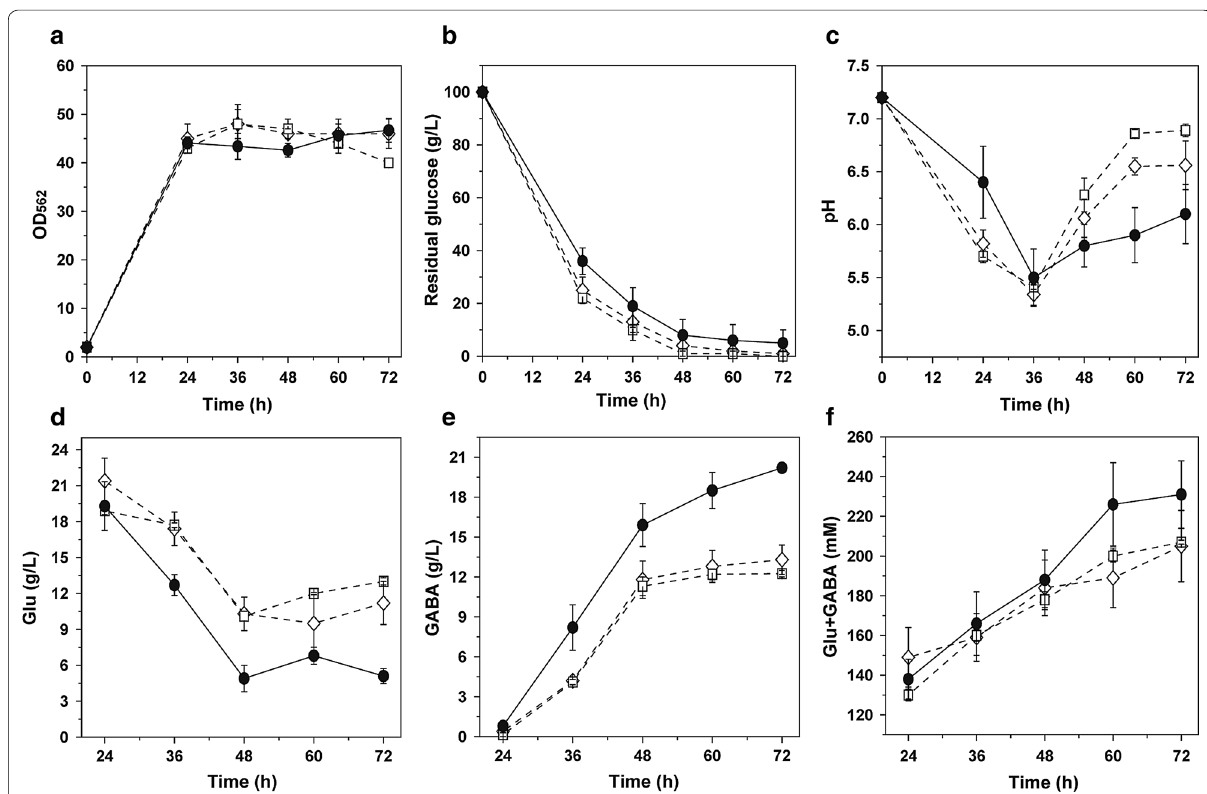
Fig. 2 GABA fermentation by gadB2 -expressing C. glutamicum strains under R4 RBS sequence with AS of 6 nt (R4a), 7 nt (R4) and 8 nt (R4b). a Cell growth, b glucose consumption, c pH variation, d Glu production, e GABA production, f total amount of Glu and GABA. Circles R4a-B2, empty diamonds in dotted line R4-B2, empty squares in dotted line R4b-B2. Averages of three independent experiments are